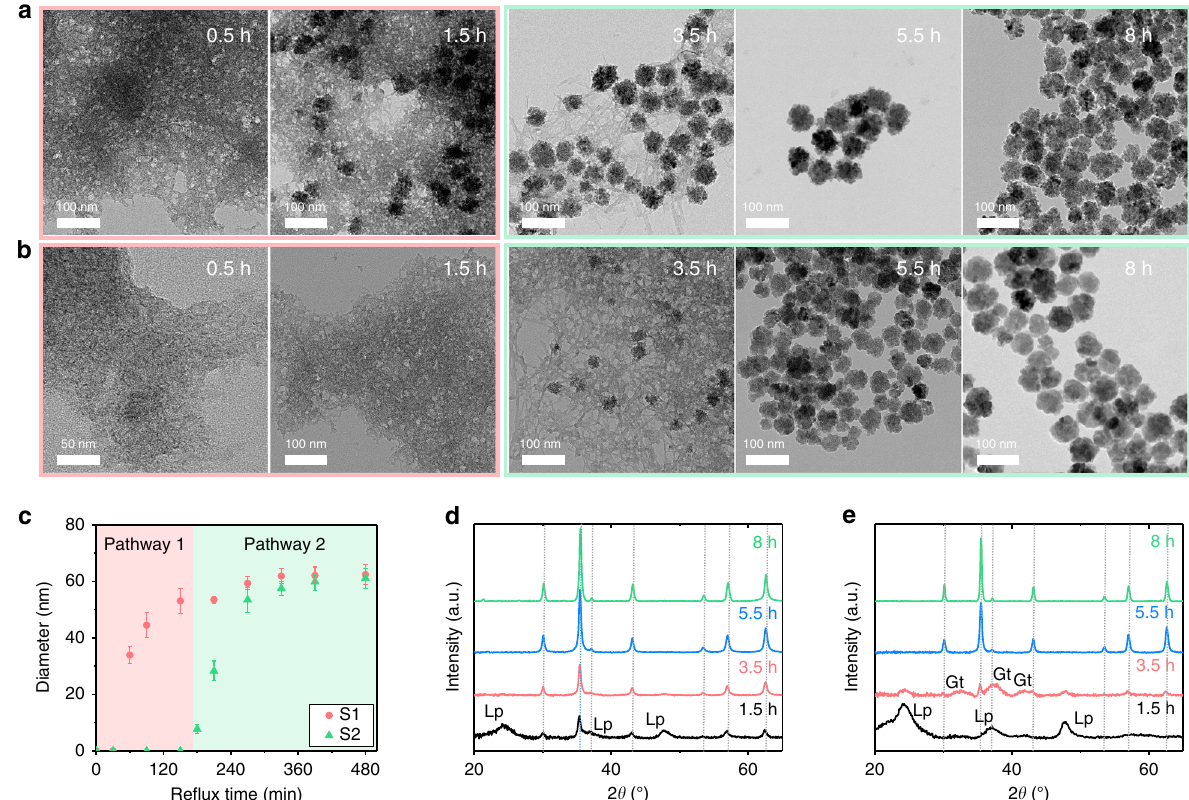
Fig. 2 Crystallization of Fe 3 O 4 mesocrystals in S1 and S2 during re fl uxing. a , b TEM images of a S1 and b S2 after 0.5, 1.5, 3.5, 5.5, and 8 h of re fl uxing. c Growth of Fe 3 O 4 mesocrystals in S1 and S2. Red (pathway 1) and green (pathway 2) indicate growth from different ferric (oxyhydr)oxide polymorphs. Diameters are mean values of the Gaussian function measured from n > 200 mesocrystals in TEM images; error bars indicate standard deviations. d , e XRD patterns of d S1 and e S2. Lepidocrocite (Lp), goethite (Gt), and magnetite (Mt) are indexed using ICDD no. 00-044-1415, 00-029-0713, and 01-086-1344 (gray dotted line),